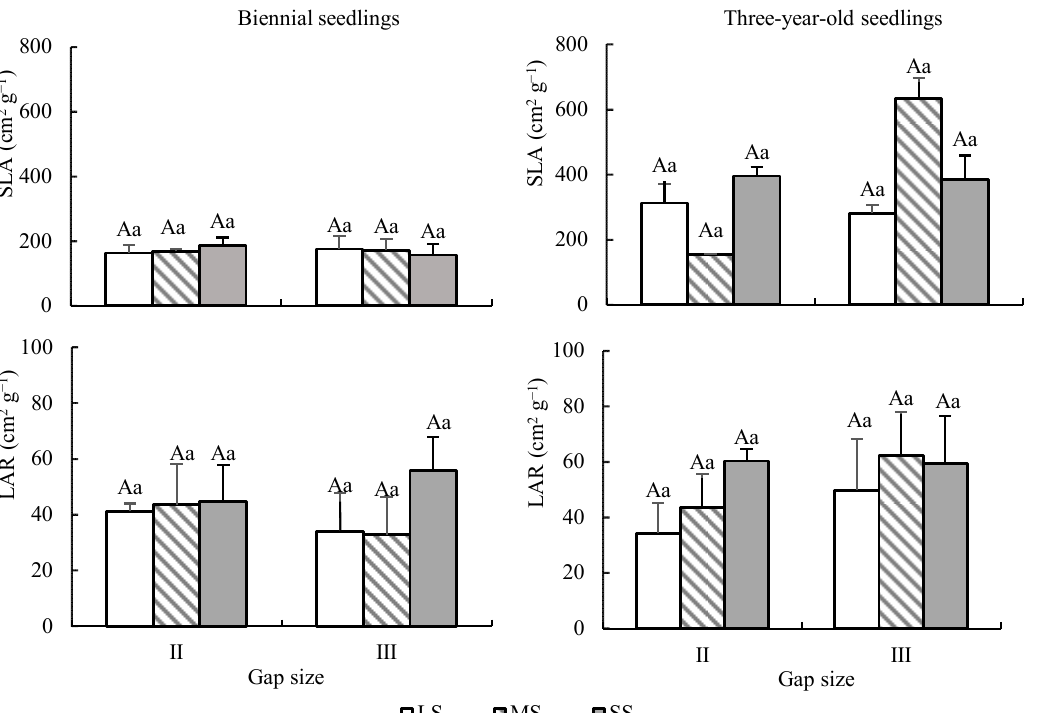
Figure 7. Dynamic changes of leaf characteristics of Quercus acutissima seedlings from different sizes of seeds under different forest gaps. LS: large seed; MS: medium seed; SS: small seed. Different capital letters indicate that there is a significant difference between different seed size groups under the same gap ( p < 0.05), and different lower letters indicate that there is a significant difference between gaps under the same seed size ( p < 0.05).